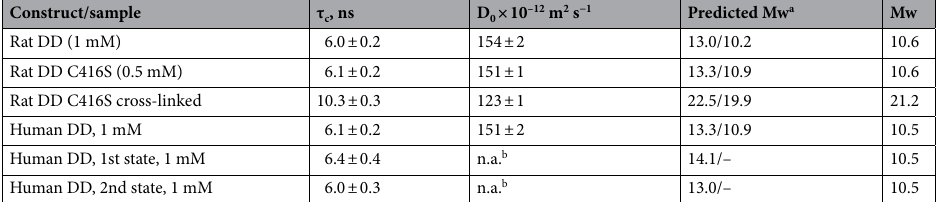
Table 1. Hydrodynamic parameters of various p75 DD constructs. a Molecular weight was predicted based on the hydrodynamic radius of the equivalent sphere according to the work 22 . The first number is estimated based on rotational diffusion/second number is obtained from the D 0 values. b Translational diffusion cannot be measured for the two states